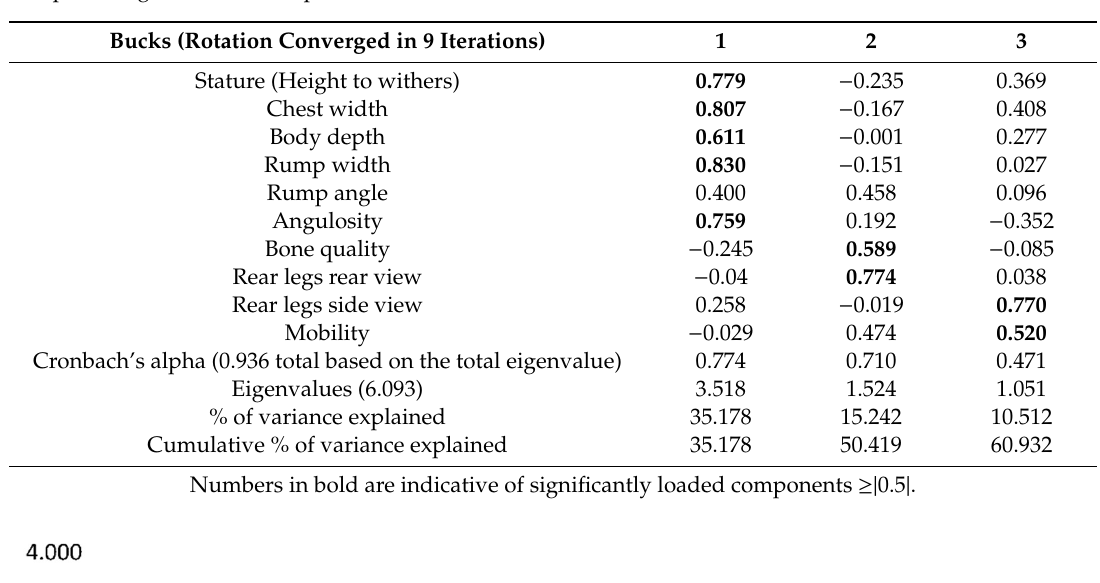
Table 3. LAS varimax with Kaiser normalization rotated component loadings, eigenvalues and percentage of variance explained for Murciano-Granadina bucks.